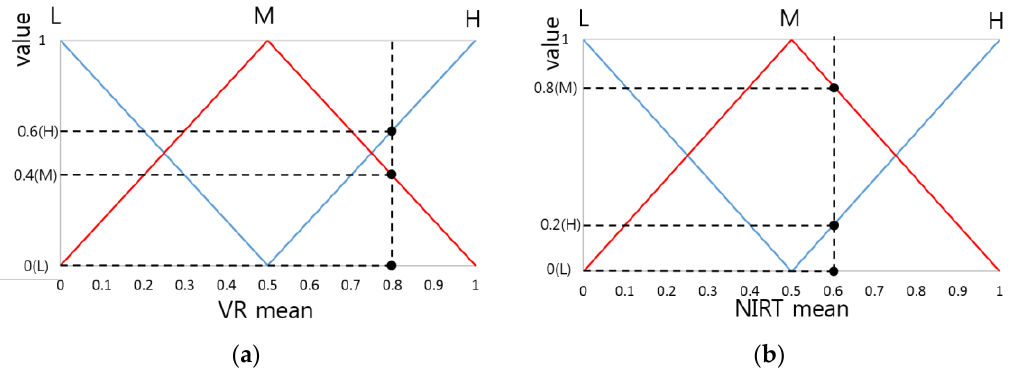
( b ) Figure 5. Banknote fitness classification system membership functions: ( a ) Input membership function; ( b ) Output membership function. For example, through the input membership function, a VR mean value of 0.8 has output values of 0 (L), 0.4 (M), and 0.6 (H), as shown in Figure 6. Furthermore, if the mean value of NIRT is 0.6, it has output values of 0 (L), 0.8 (M), and 0.2 (H). Based on these two types of output values, nine